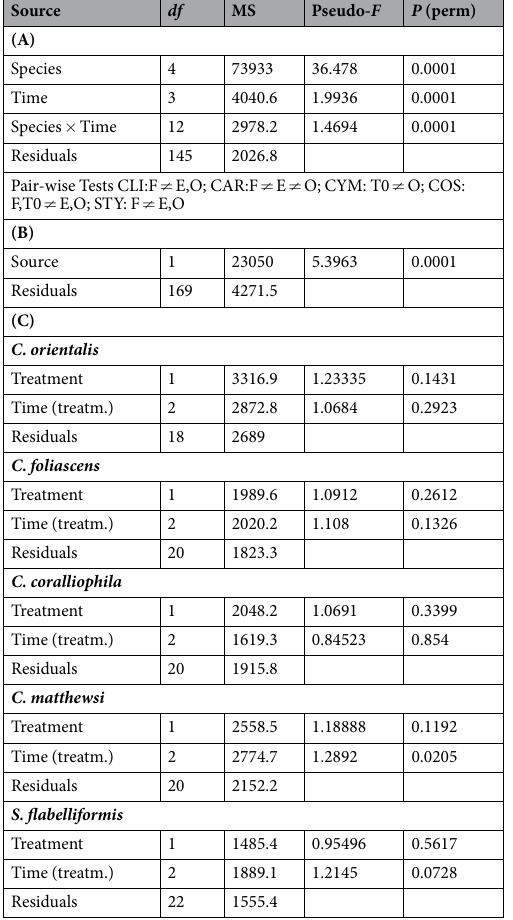
Table 3. PERMANOVA analyses of the microbiome community. PERMANOVA with (A) species and time as factors, (B) source as factor (sponge host vs. seawater) and, (C) sediment treatment and time (nested to treatment) as fixed factors for all 5 sponge species. In pair-wise tests, F: field control, T0: time 0 control, E: sampling at the end of the exposure time (i.e. 30 d), O: sampling after the 14 d observational period; CAR for C. foliascens , CYM for C. coralliophila , CLI for C. orientalis , COS for C. matthewsi and STY for S. flabelliformis ; Control (C) and smothered (S) within